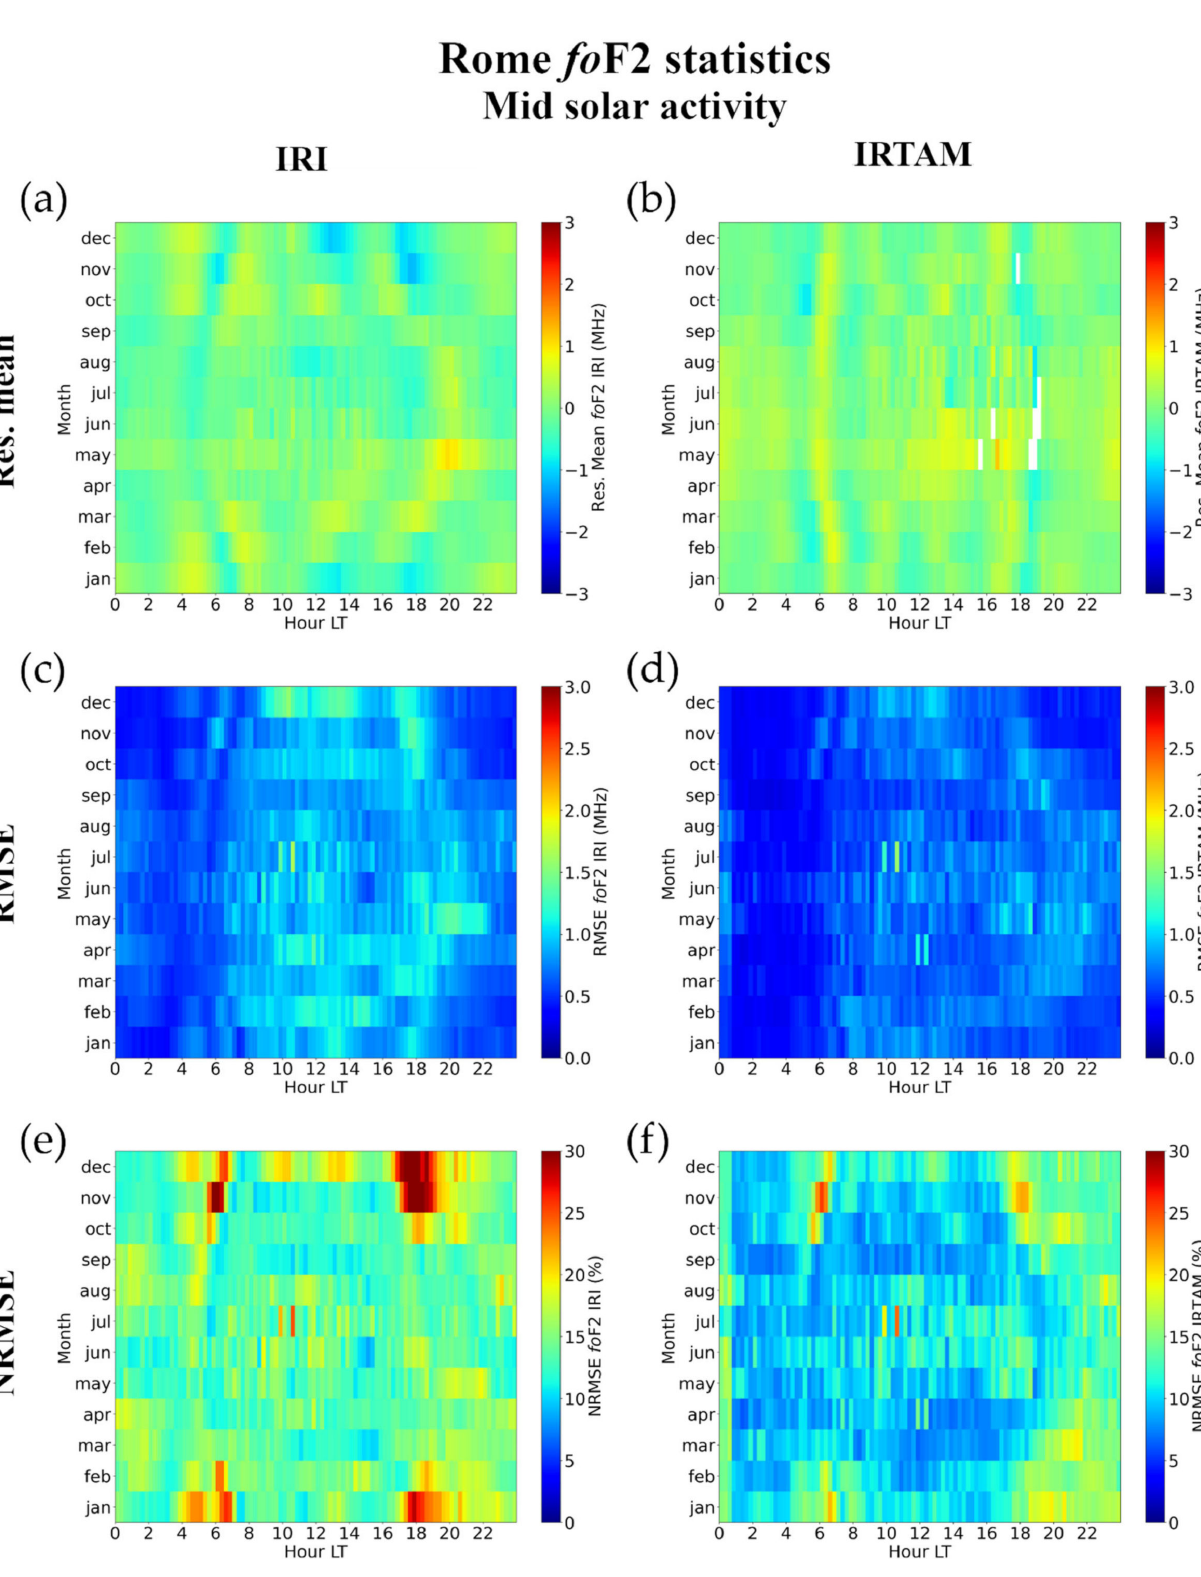
Figure 11. Same as Figure 10 but for MSA